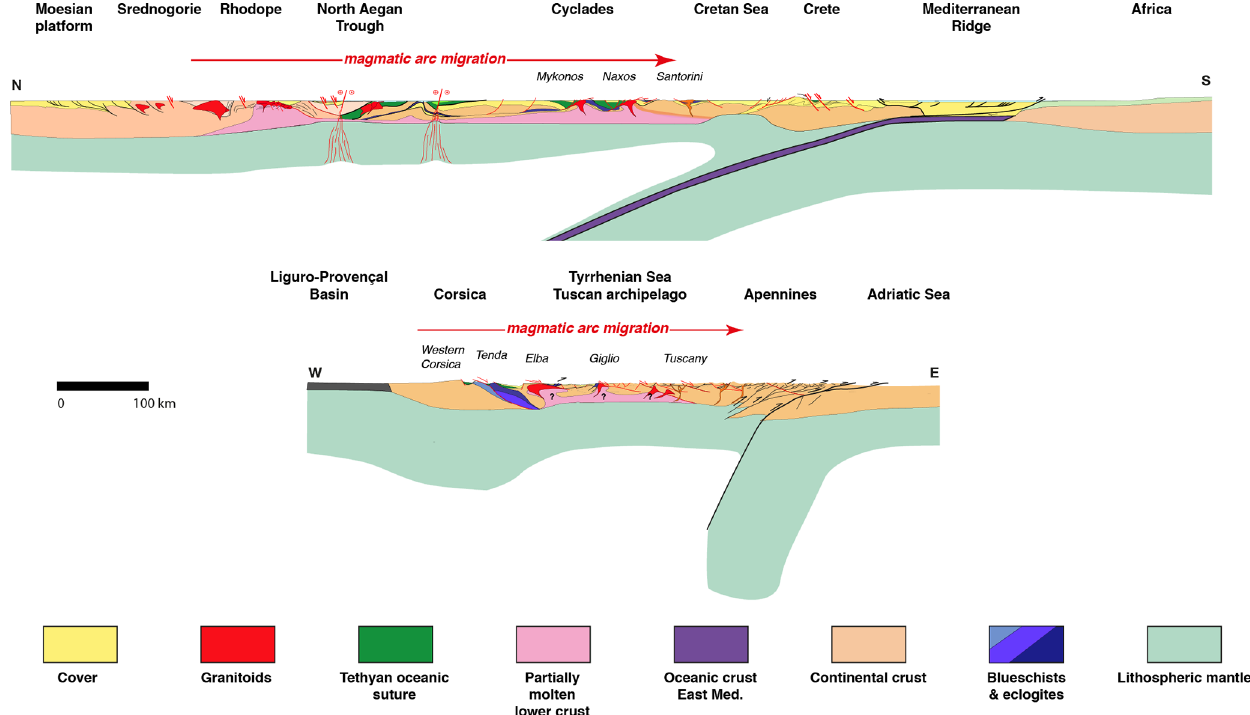
Figure 4. Two lithospheric-scale cross sections of the Aegean domain (Jolivet and Brun, 2010) and the northern Tyrrhenian Sea and the Apennines (Jolivet et al.,